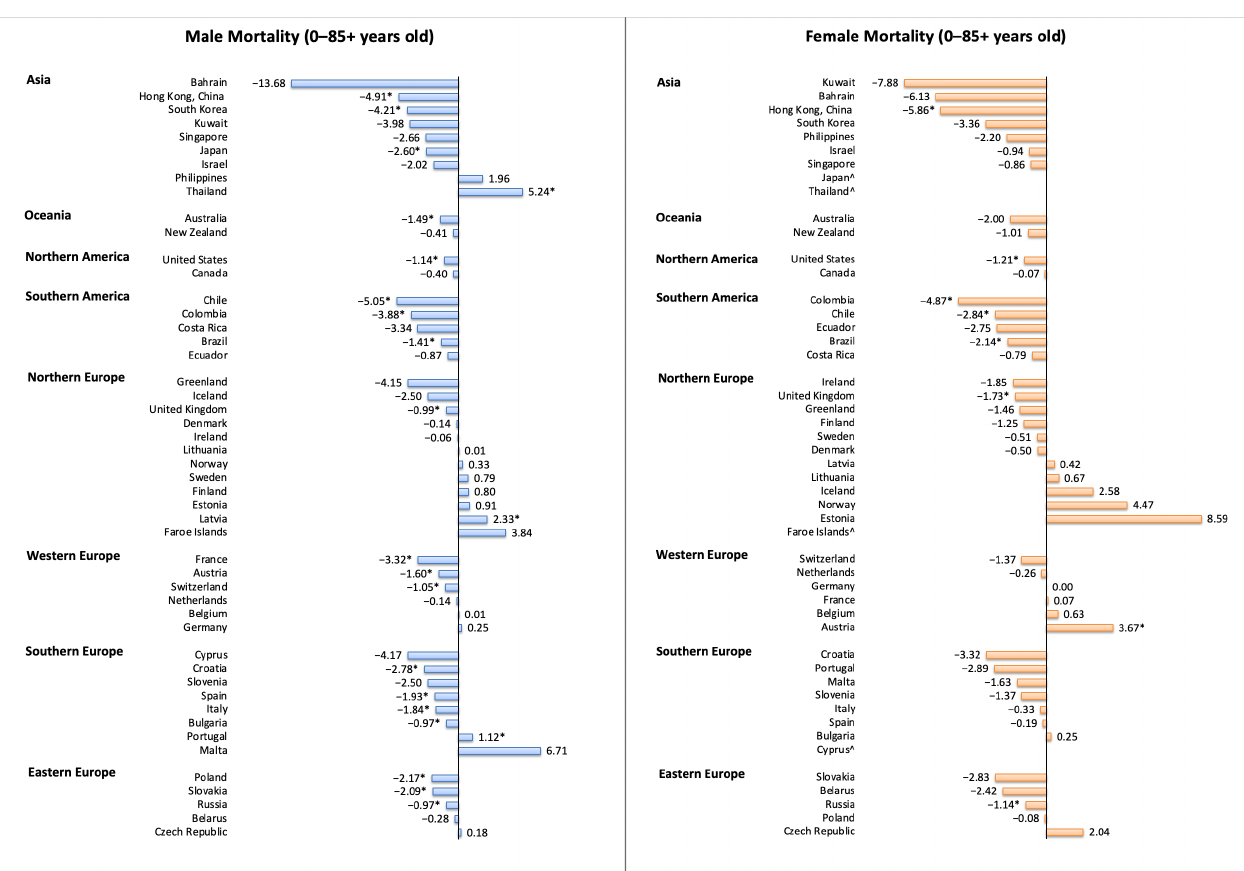
Figure 5. The AAPC of the mortality of esophageal cancer in individuals aged 0-85+ years